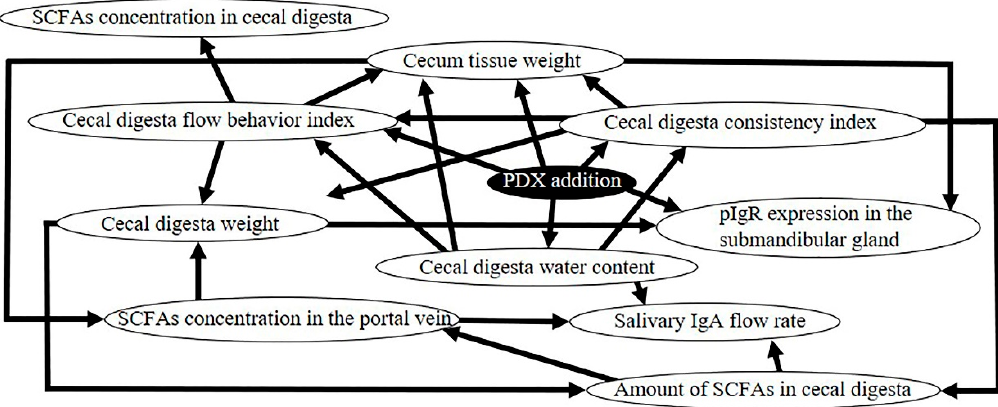
Figure 5. Bayesian network showing the causal effects between the following parameters, upon PDX ingestion: Salivary IgA flow rate, SCFA concentration in the portal vein, SCFA concentration in the cecal digesta, amount of SCFAs in cecal digesta, cecum tissue weight, cecal digesta weight, cecal digesta water content, cecal digesta consistency index, cecal digesta flow behavior index, and pIgR expression in submandibular gland. Causes and effects are indicated by arrowheads and lines, respectively.